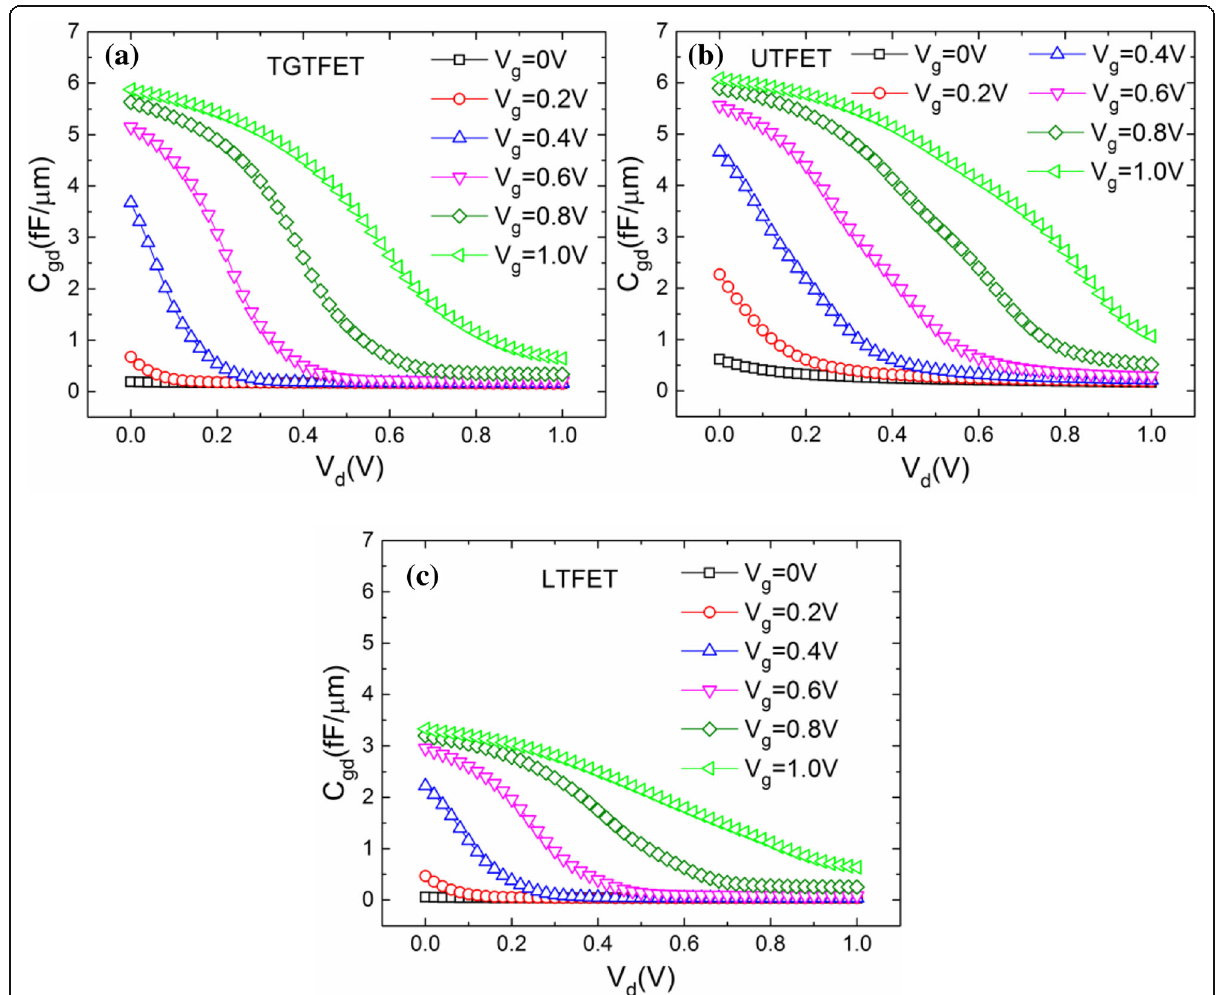
Fig. 15 C gd characteristics of a TGTFET, b UTFET, and c LTFET versus V d under different V